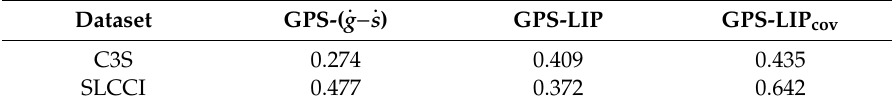
Figure 9. Scatterplots of VLM values derived with classical approach ( method for C3S and SLCCI altimetry datasets over 1993–2015. VLM estimates agree very well at the SPLIT and DUBROVNIK TGs, while di ff erences increase north of SPLIT. Table 5. Root mean square deviation of GPS observations and VLM estimates (1993–2018). Column 1: dataset name; columns 2–4: di ff erence of VLM estimates from GPS and classical approach, from GPS and LIP, and from GPS and LIP cov , respectively. All data are in mm y − 1